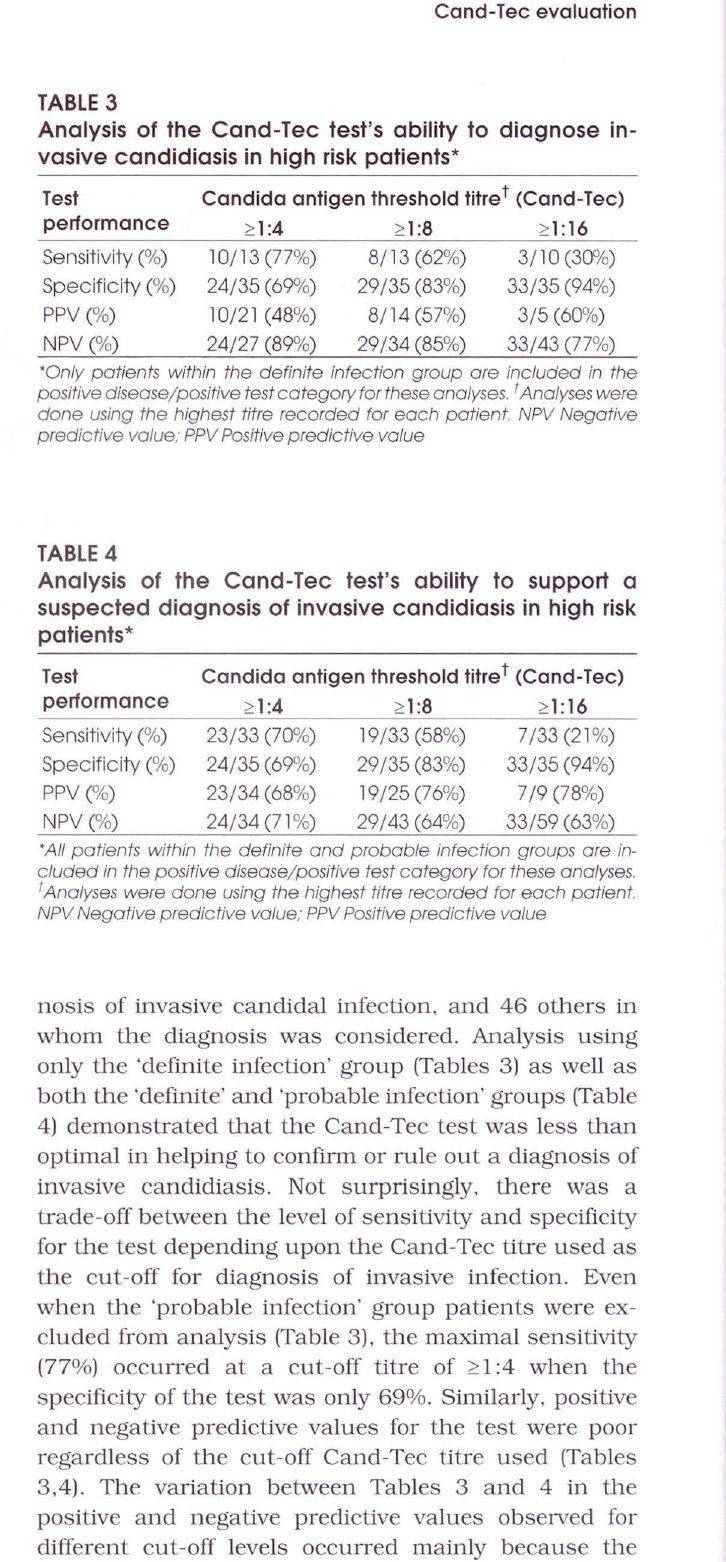
nosis of invasive candida! infection, and 46 others in whom the diagnosis was considered. Analysis using only the 'definite infection' group (Tables 3) as well as both t11e 'definite' and 'probable infection' groups (Table 4) demonstrated that the Cand-Tec test was less than optimal in helping to confirm or rule out a diagnosis of invasive candidiasis. Not surprisingly, there was a trade-off between tl1e level of sensitivity and specificity for tl1e test depending upon the Cand-Tec titre used as tl1e cut-off for diagnosis of invasive infection. Even when the 'probable infection' group patients were ex cluded from analysis (Table 3), the maximal sensitivity (77%) occurred at a cut-off titre of ::::1:4 when tl1e specificity of the test was only 69%. Similarly,